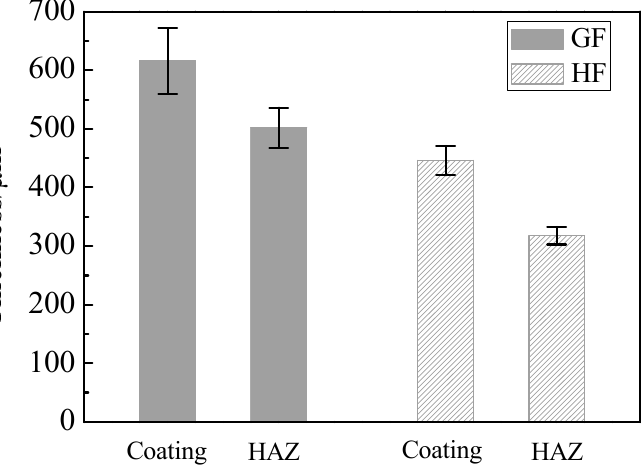
Figure 5. Thickness of coating and HAZ.